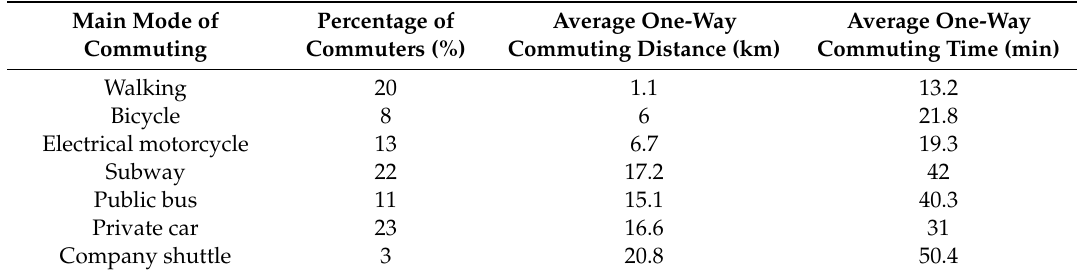
Table 2. Basic commuting